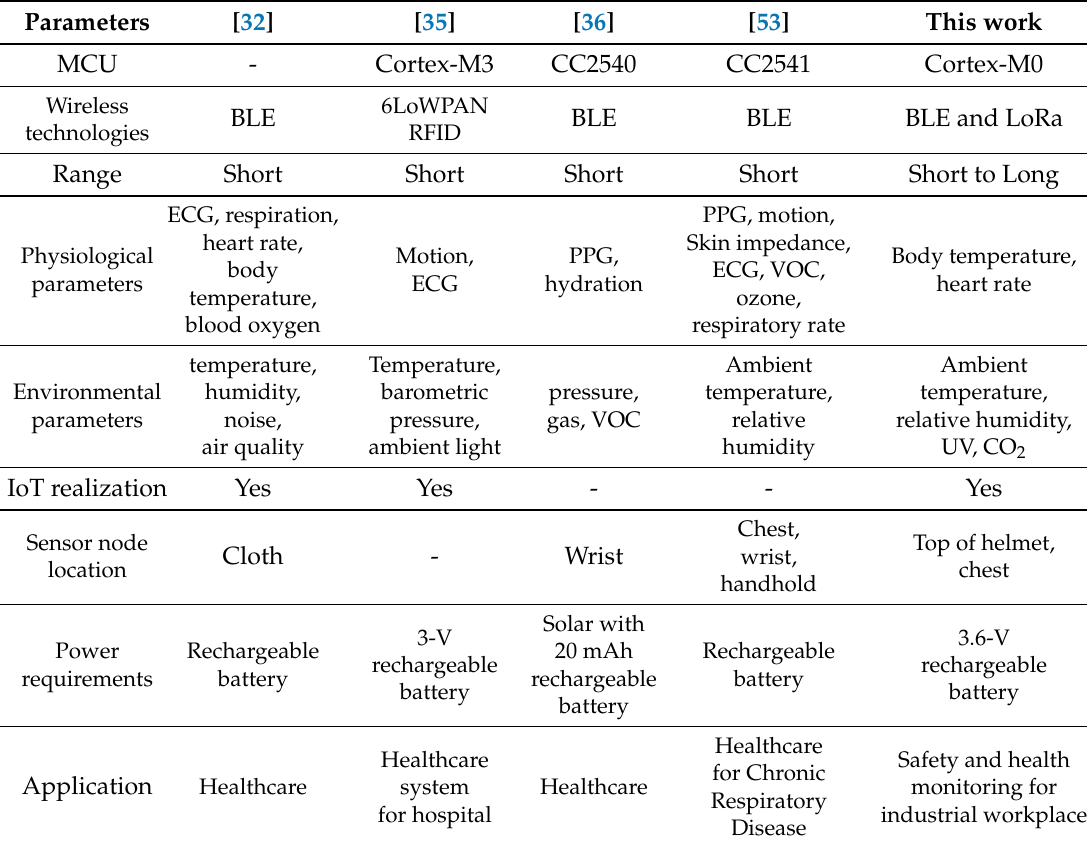
Table 4. Comparisons of wearable environmental and physiological monitoring